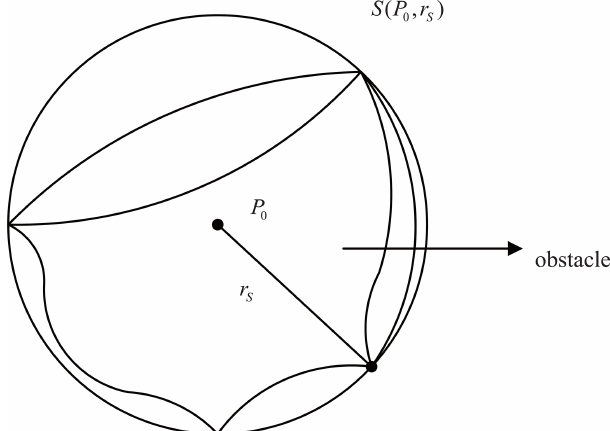
Figure 1. The obstacle uses sphere